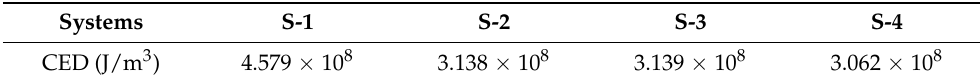
Table 2. The cohesive energy density of HTPE binders.